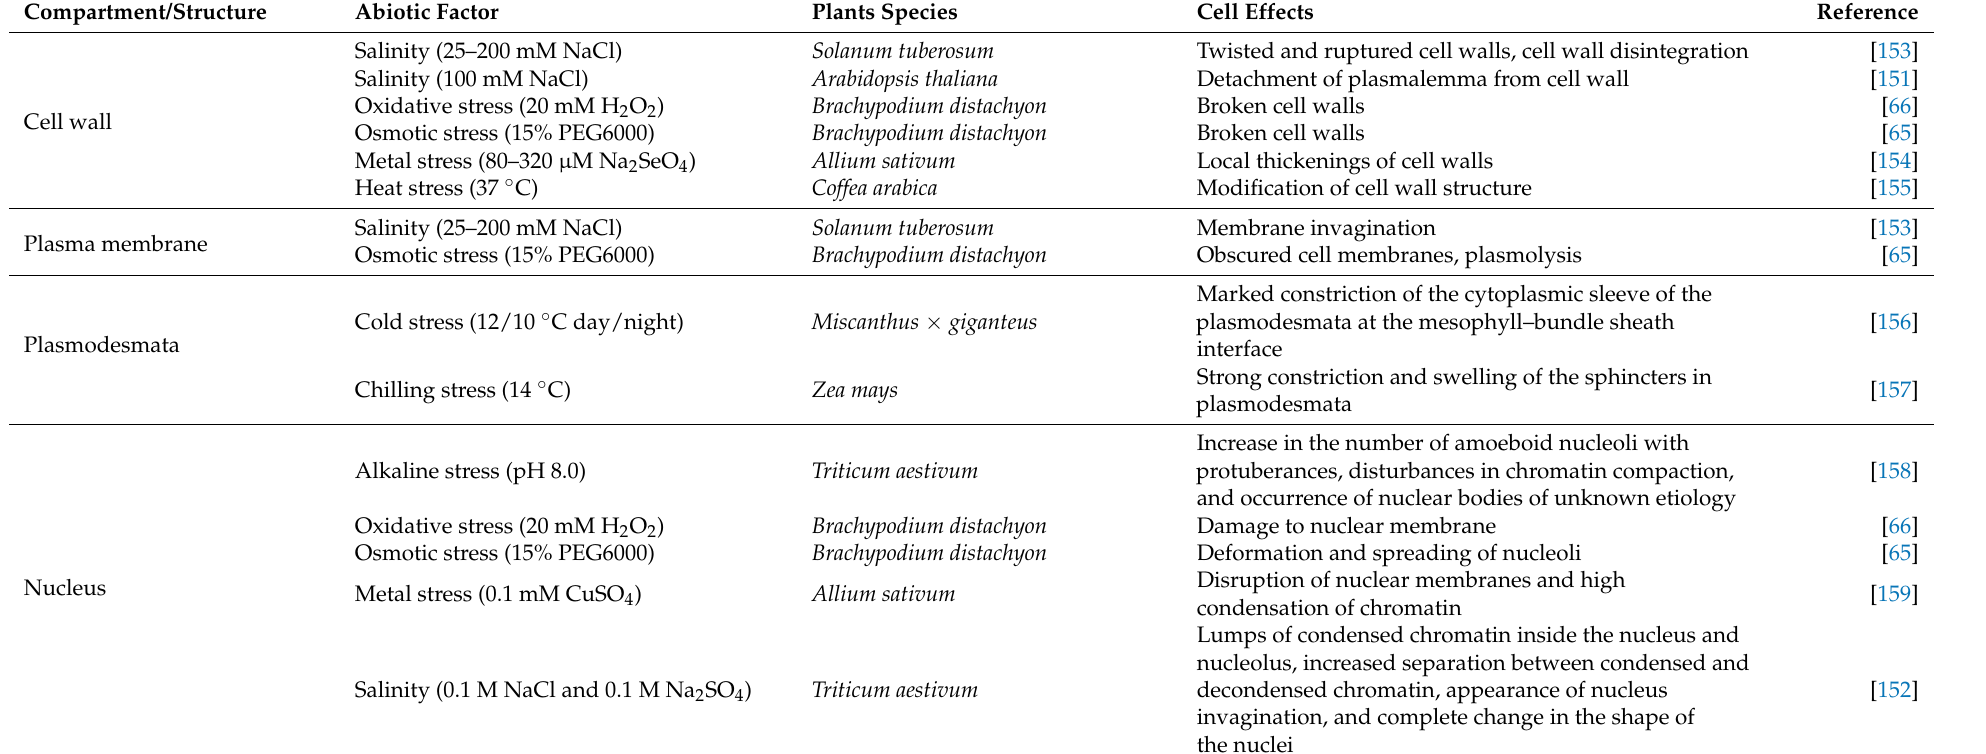
Table 2. Effects of various abiotic stress factors on qualitative ultrastructural characteristics of plant model